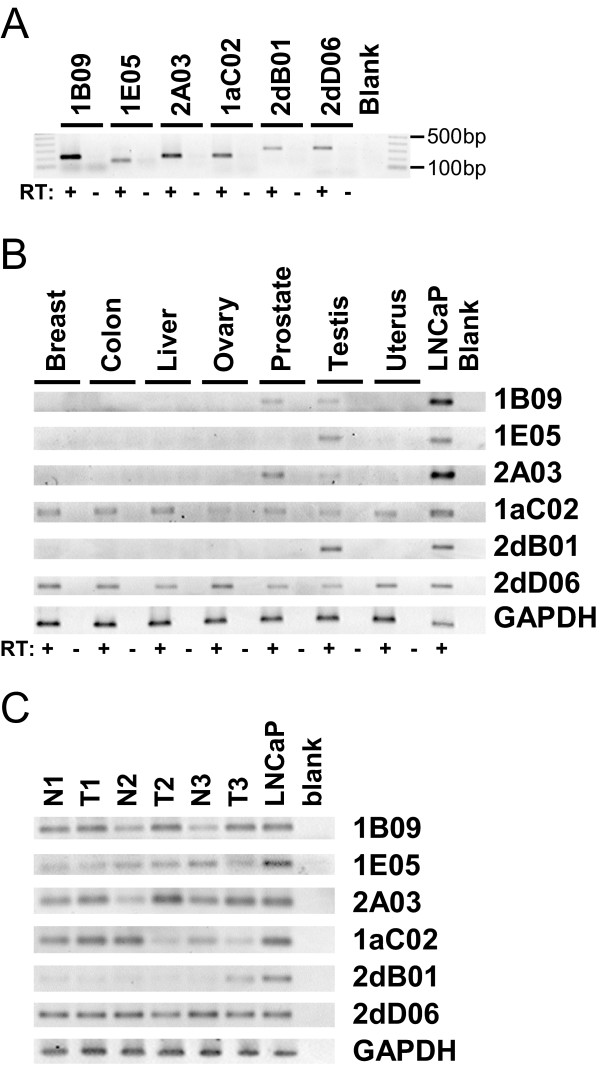
The novel subtracted clones were expressed in a variety of human tissues. (A) RT-PCR was performed with primer pairs specific for each of six novel clones using cDNA from the LNCaP hollow fibre model. RT indicates the presence or absence of Reverse Transcriptase. (B) RT-PCR was performed using cDNAs generated from normal human tissues with each of the six novel clones. All clones were expressed in at least one of the normal tissues. (C) RT-PCR was performed using cDNAs generated from three samples of prostate cancer (T1 – T3) and their respective matched normal samples (N1 – N3). All six of the clones were expressed in at least one of these samples.